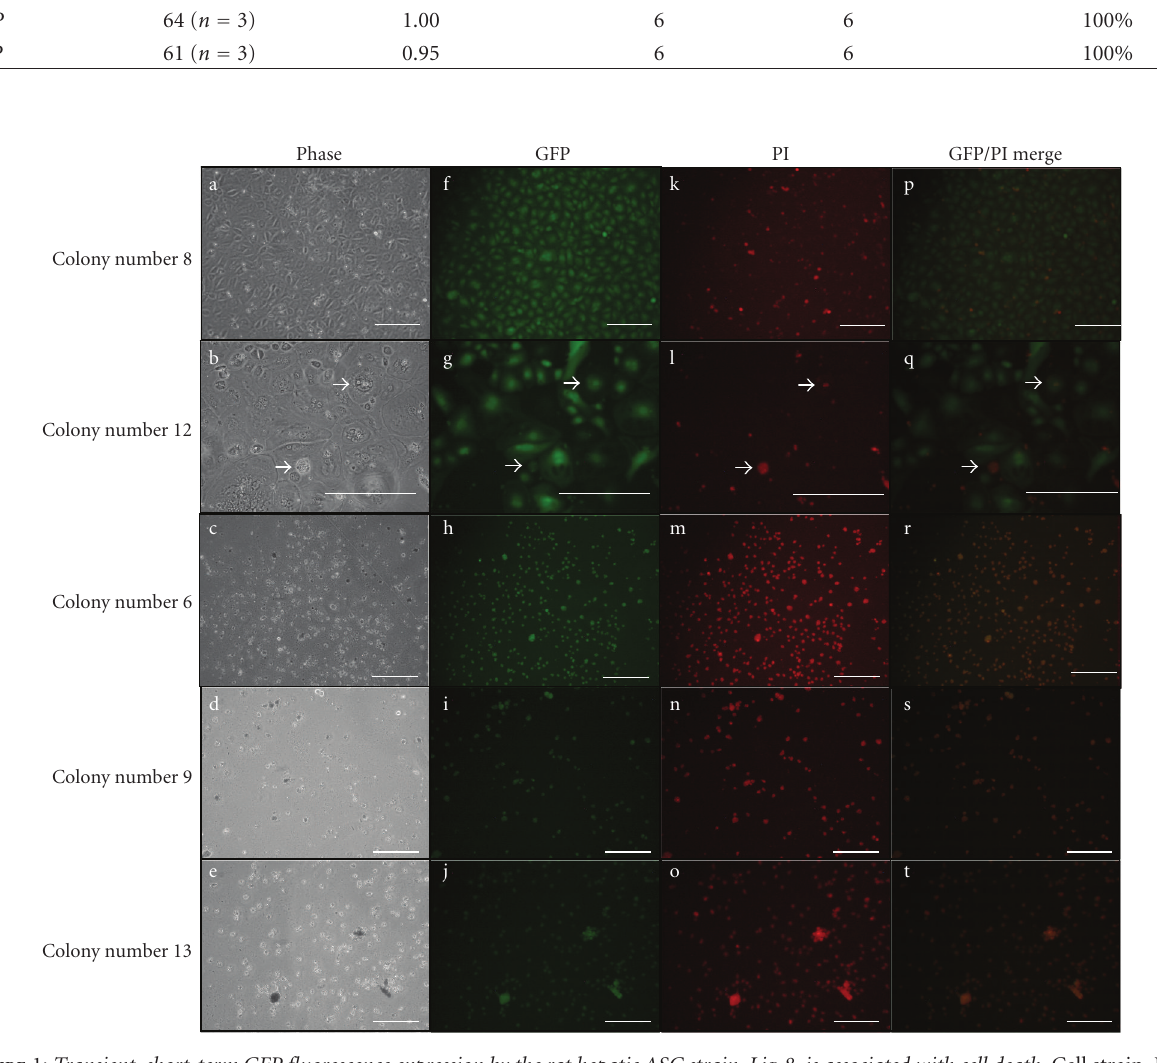
Figure 1: Transient, short-term GFP fluorescence expression by the rat hepatic ASC strain, Lig-8, is associated with cell death . Cell strain, Lig-8, was transfected with the pEGFP-N3 expression vector. Shown are images of 5 independent colonies transiently expressing GFP fluorescence at 72–96 hours posttransfection. Shown are the phases (a)–(e), GFP-fluorescence (f)–(j), propidium iodide (PI) fluorescence (k)–(o), and merged GFP and PI fluorescence (p)–(t) images. Arrows highlight specific examples of cells double-positive for GFP and PI fluorescence in Colony no. 12. Scale bar is equivalent to 100 μ